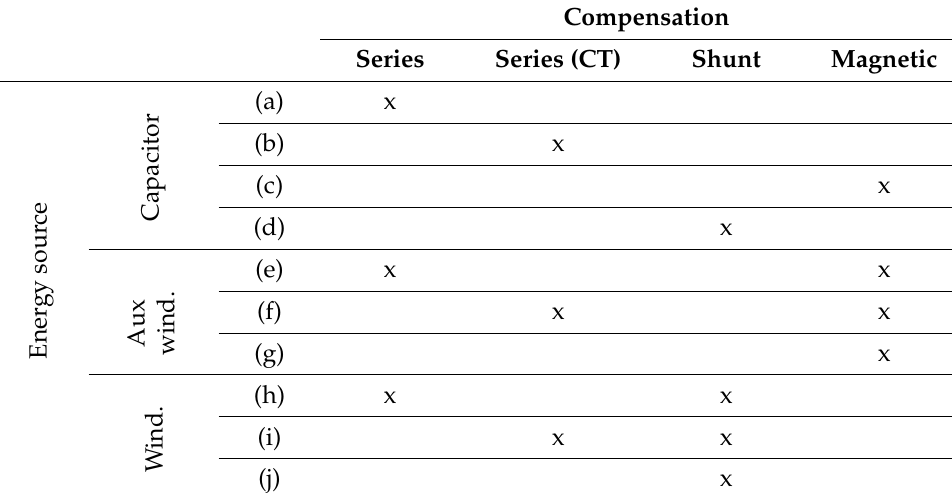
Table 1. Compensation provided by HDT